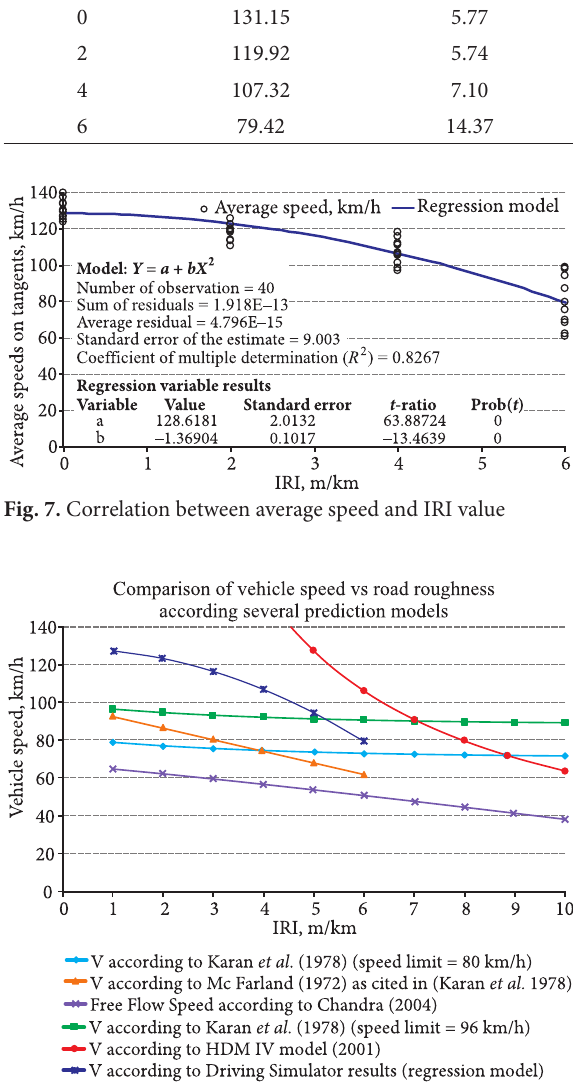
Table 3. Speed on tangents as a function of IRI value Speed on tangents IRI, m/km Average value,